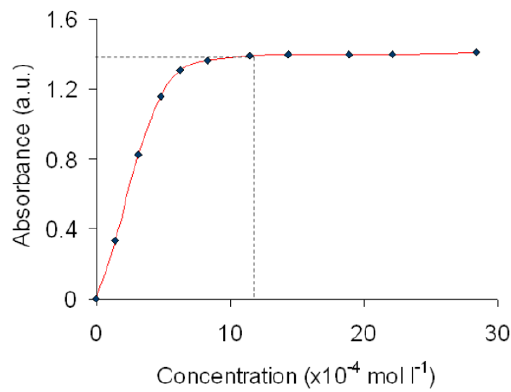
Figure 2. Absorbance as a function of SDBS concentration in aqueous solution for the band K